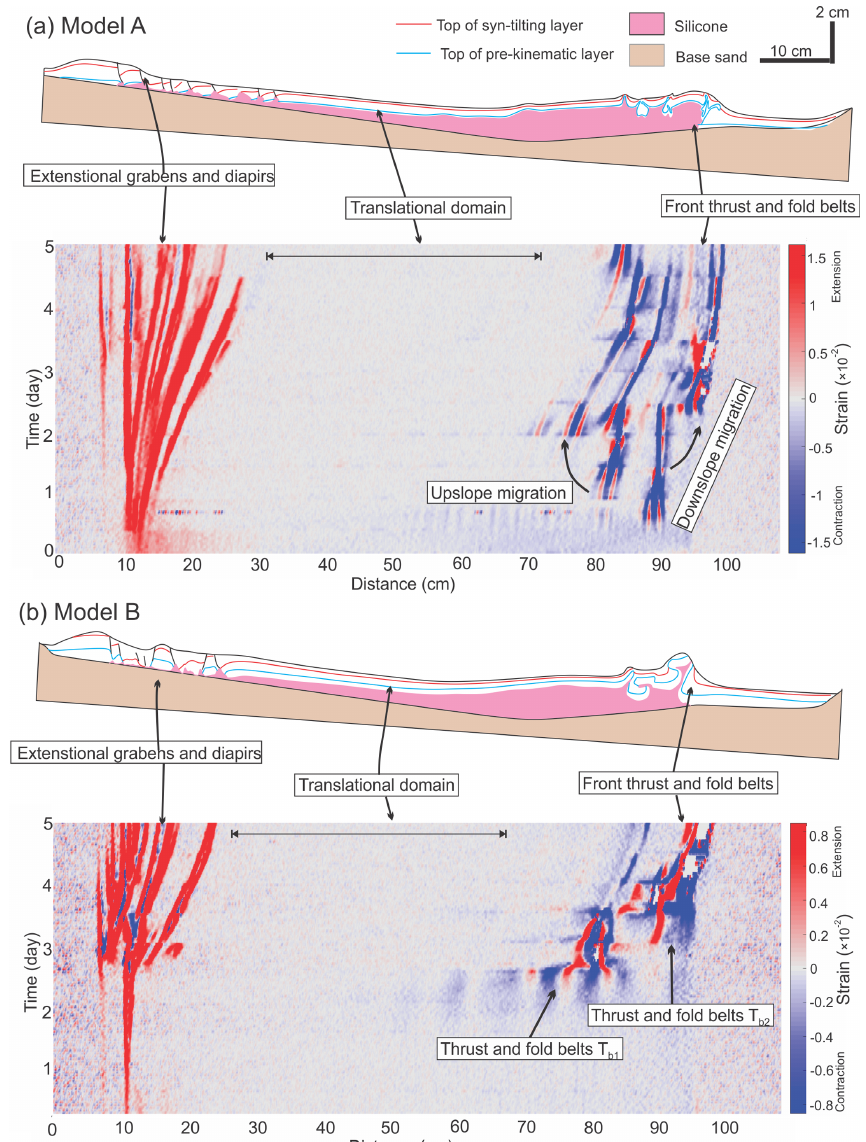
Figure 5. (a) Structural styles and kinematic domain partition in central section of Model A. The strain evolution diagram (showing incre- mental strain at 1h intervals, or strain rate in 1/h) along the central section beneath shows the initiation of extensional and contractional structures and how they evolve in space and time. Note the persistent translational domain. (b) Structural styles and kinematic domain parti- tion in central section of Model B. The strain evolution diagram (showing incremental strain at 1h intervals, or strain rate in 1/h) along the central section shows the evolution of extensional and contractional structures in space and time. Note the first contractional structure T b 1 occurs in the mid stage of the